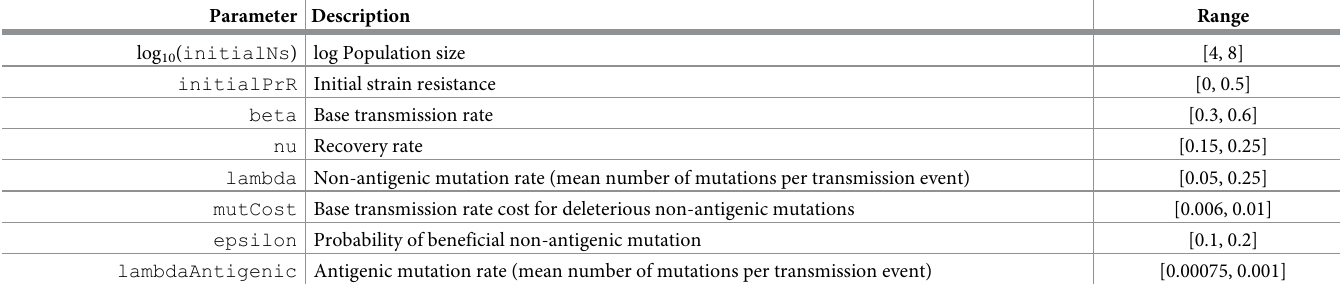
Table 1. Range of perturbed simulation parameters. Each parameter was sampled uniformly over the indicated range. Parameter